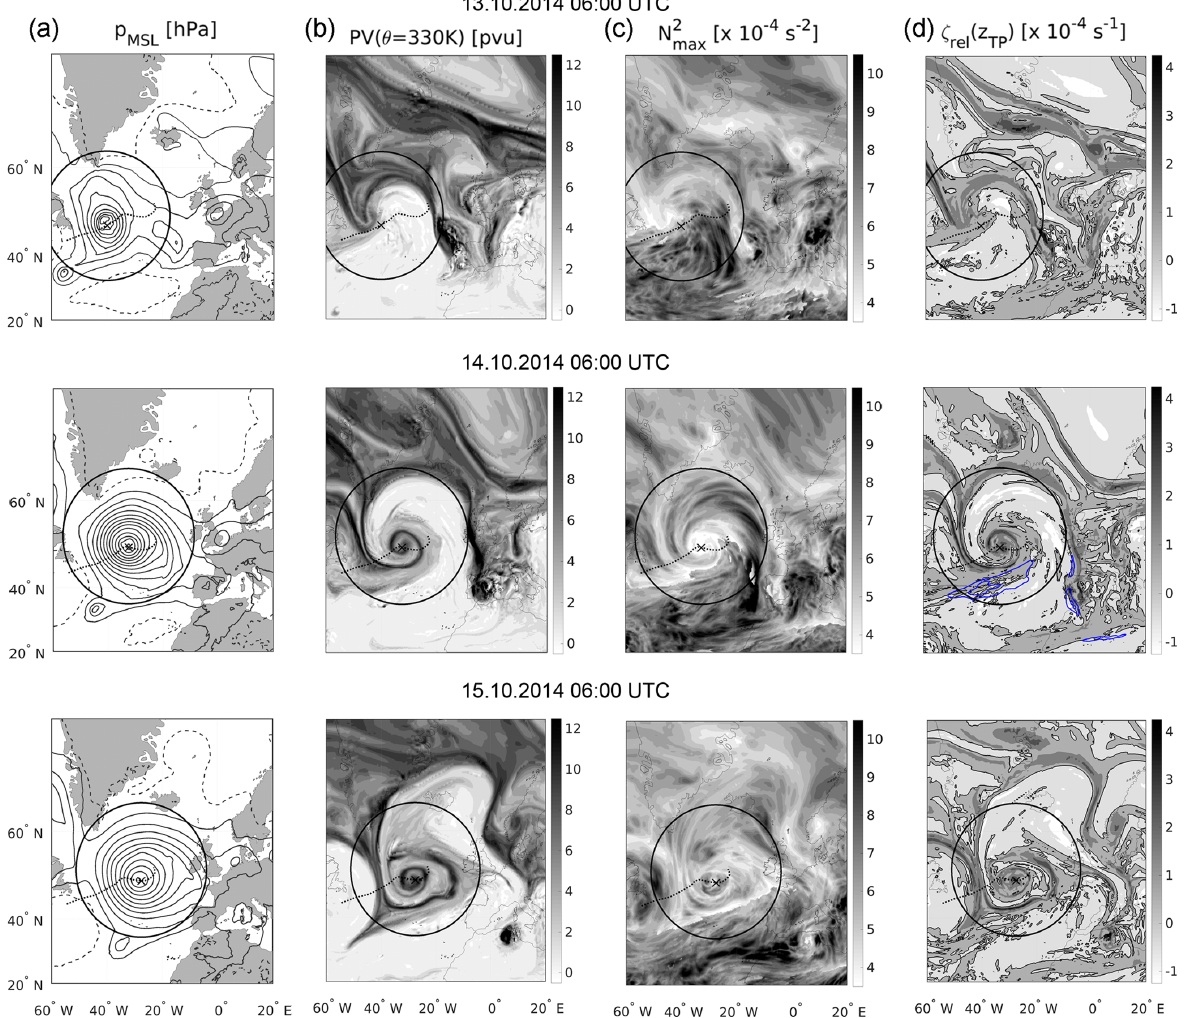
Figure 3. Evolution of a baroclinic wave-breaking event as seen in ECMWF IFS analysis data. The middle row represents 14 October 2014 at 06:00UTC (the point in time of maximum cyclone intensity), and the upper and lower row show the situation 24h prior and past the maximum intensity. Column (a) shows the pressure at mean sea level (solid lines p msl ≤ 1013hPa, dashed lines p msl > 1013hPa, in steps of 5hPa), (b) the IPV on 330K, (c) the maximum of static stability N 2 max within 3km above the thermal tropopause as an indicator for the TIL strength, and (d) the relative vorticity at lapse rate tropopause height. Blue lines in the middle row show 40 and 50ms − 1 horizontal wind speed isolines at 200hPa. The dashed black line shows the path of migration of the tracked cyclone, with the position of the cyclone centre at the point in time of the meteorological field displayed marked by the black × . Black circles show the 15 ◦ radius used for the composites. Note the deformation of the circles due to the mercator